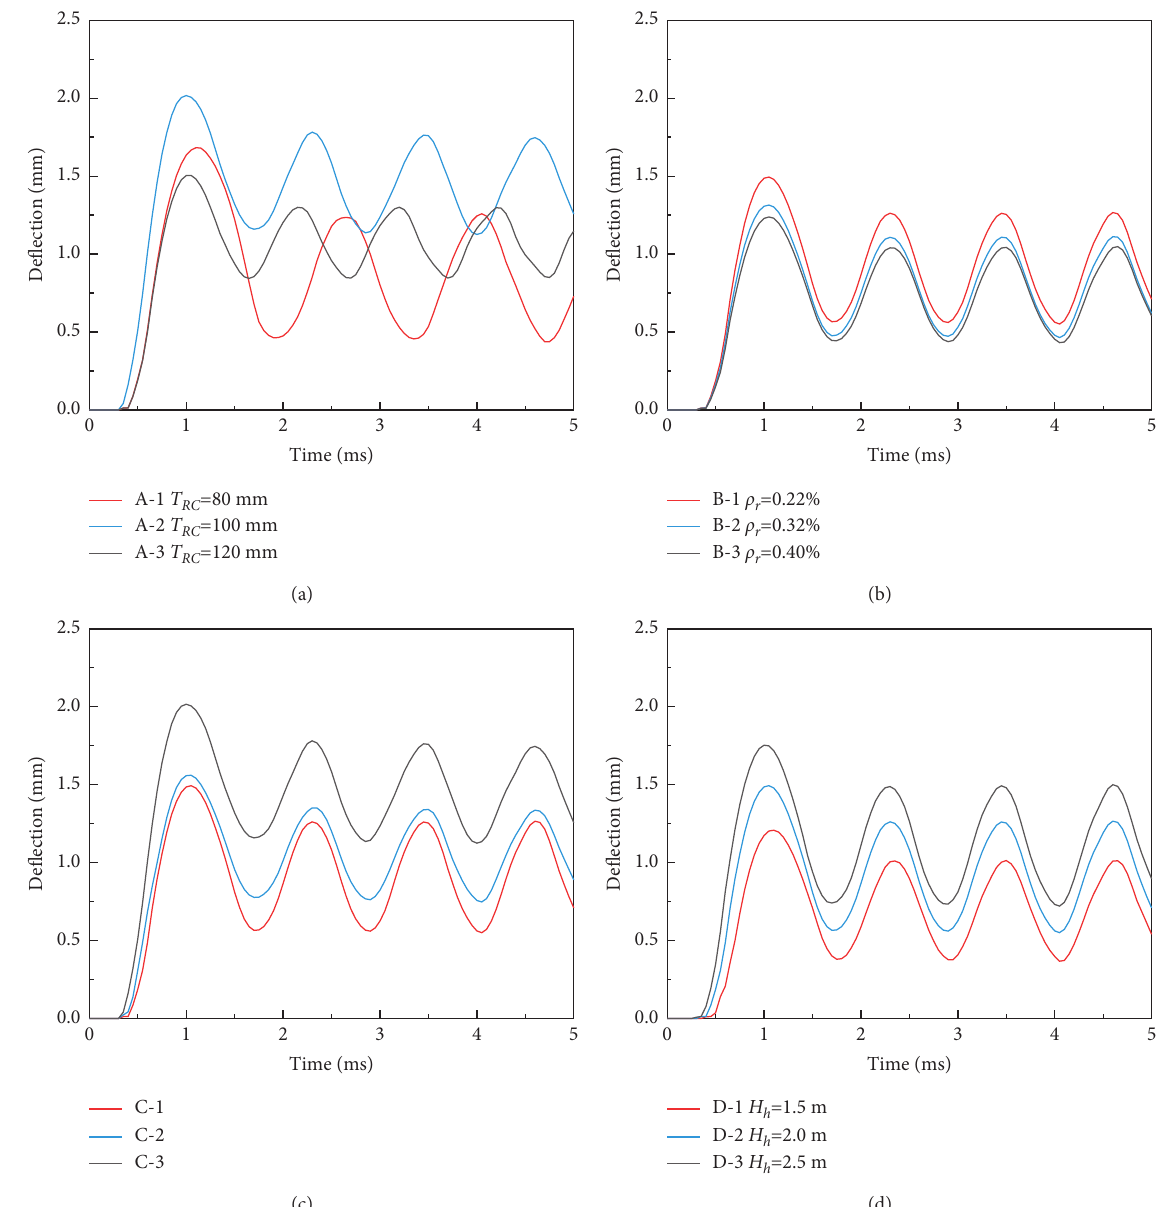
Figure 9: Time history curves of deflection of RC slab under the first